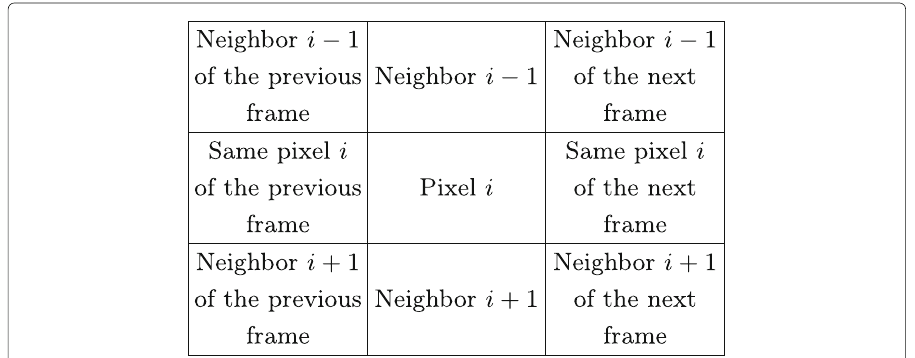
Fig. 6 Patterns for pixel neighborhood in the visual